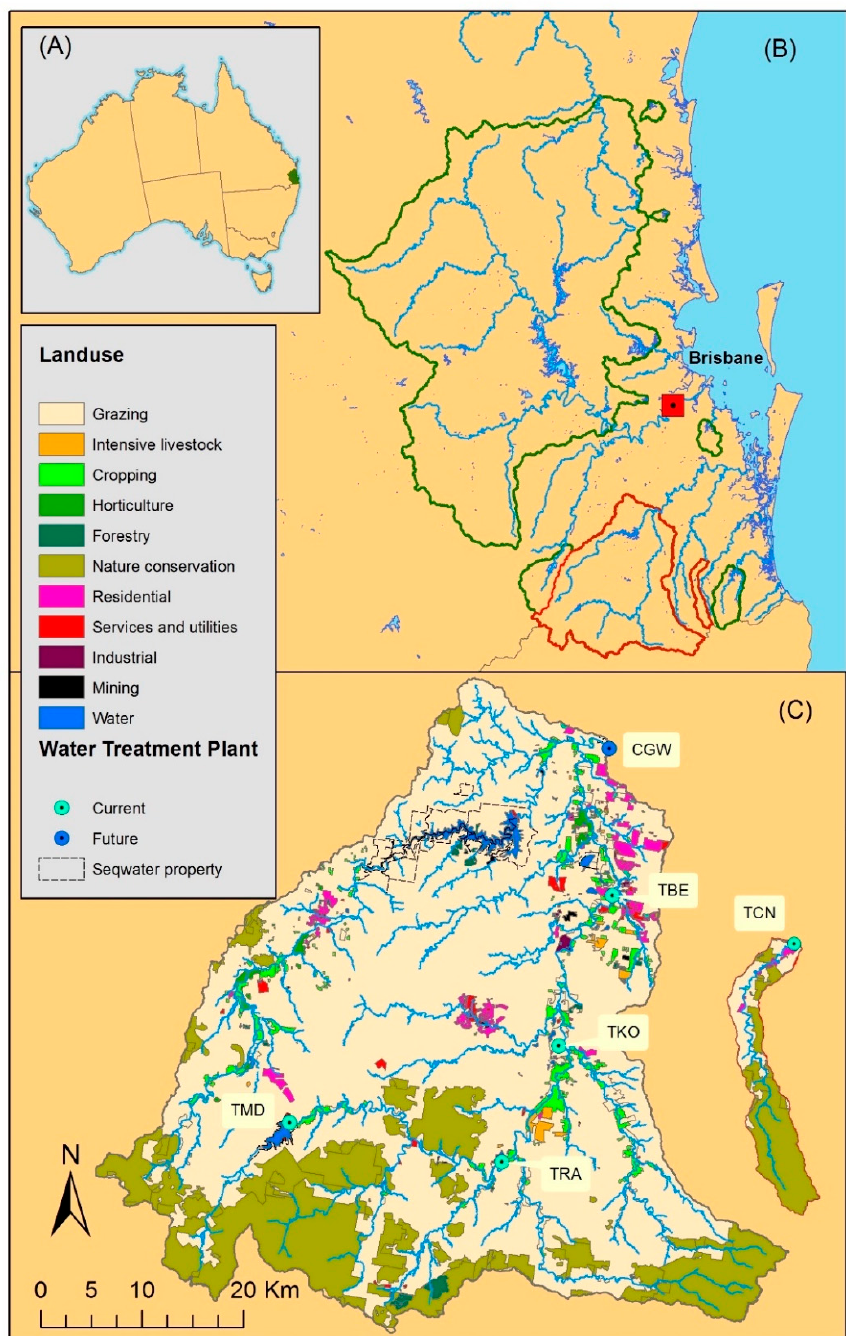
Figure 1. ( A ) Study area location on the east coast of Australia in Southeast Queensland. ( B ) Boundaries of the source water catchments with the case study catchment boundary shown in red. ( C ) Land use in the Logan-Albert catchment upstream of the WTP intakes.